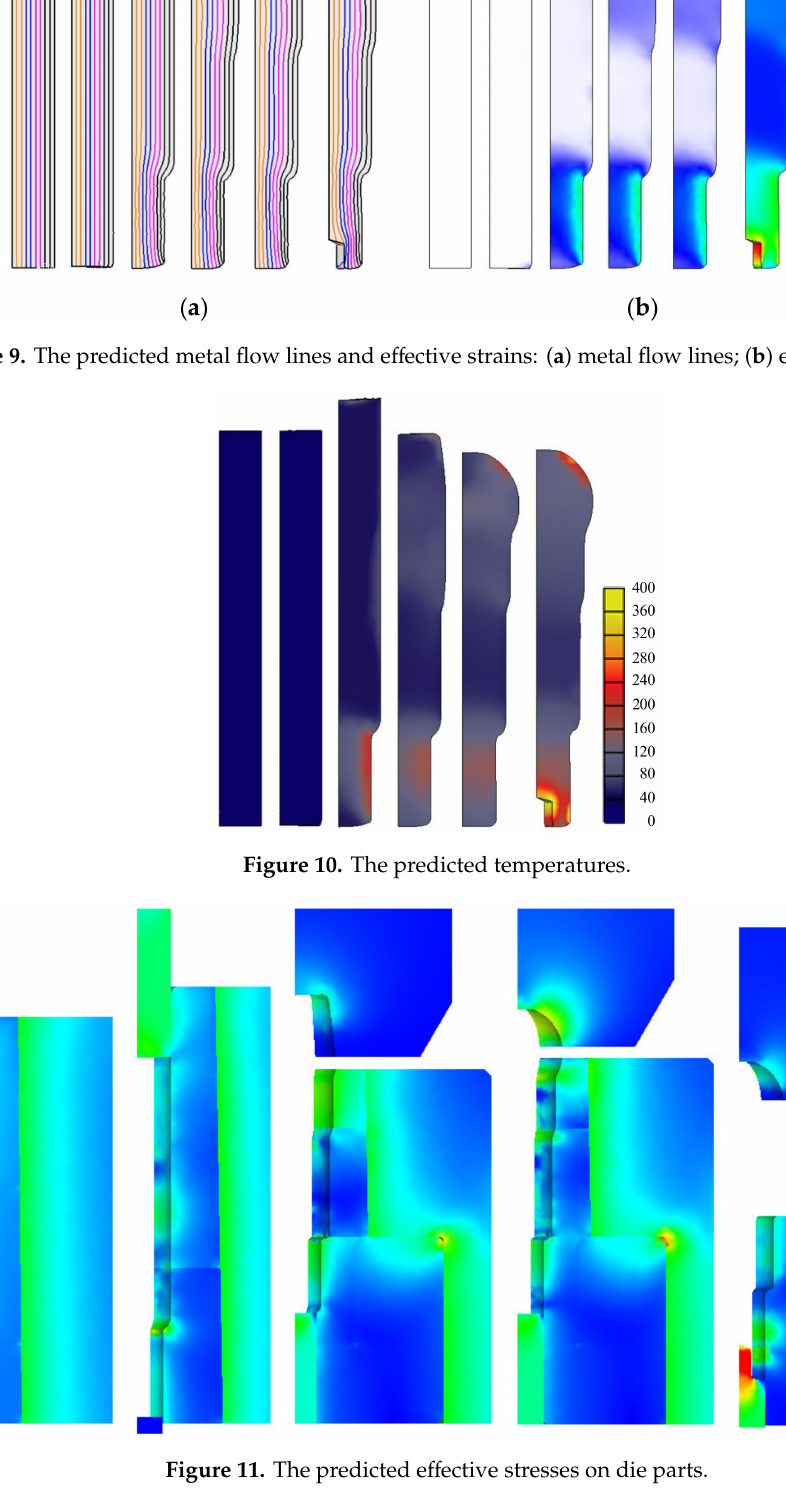
Figure 11. The predicted e ff ective stresses on die